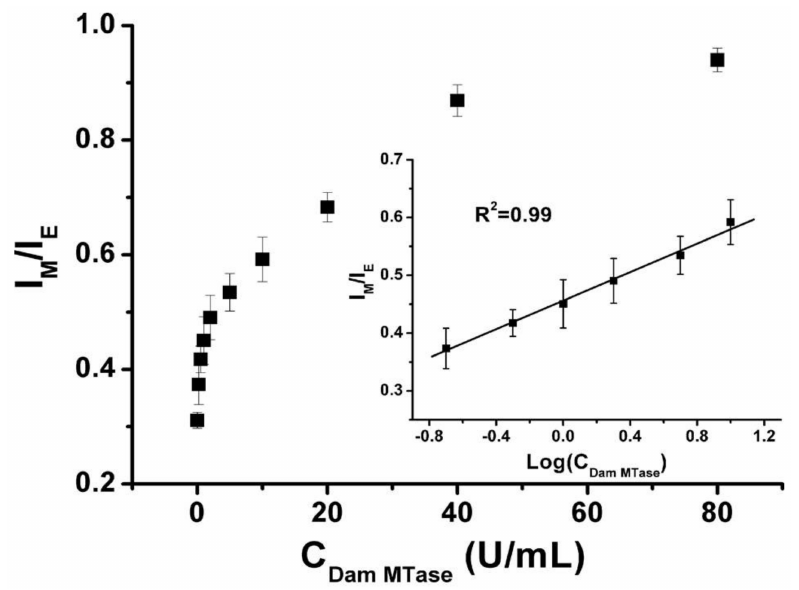
Figure 24. Plot of F monomer / F excimer (I M /I E ) value vs. dam MTase concentration (0, 0.2, 0.5, 1, 2, 2.5, 10, 20, 40, and 80 U/mL) [68].